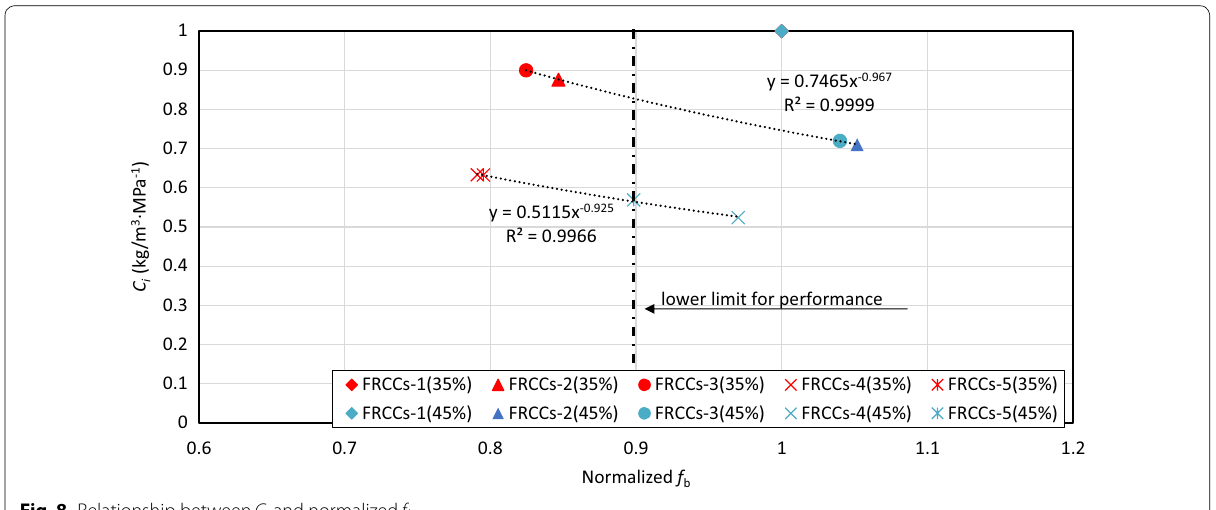
Fig. 8 Relationship between C i and normalized f b .